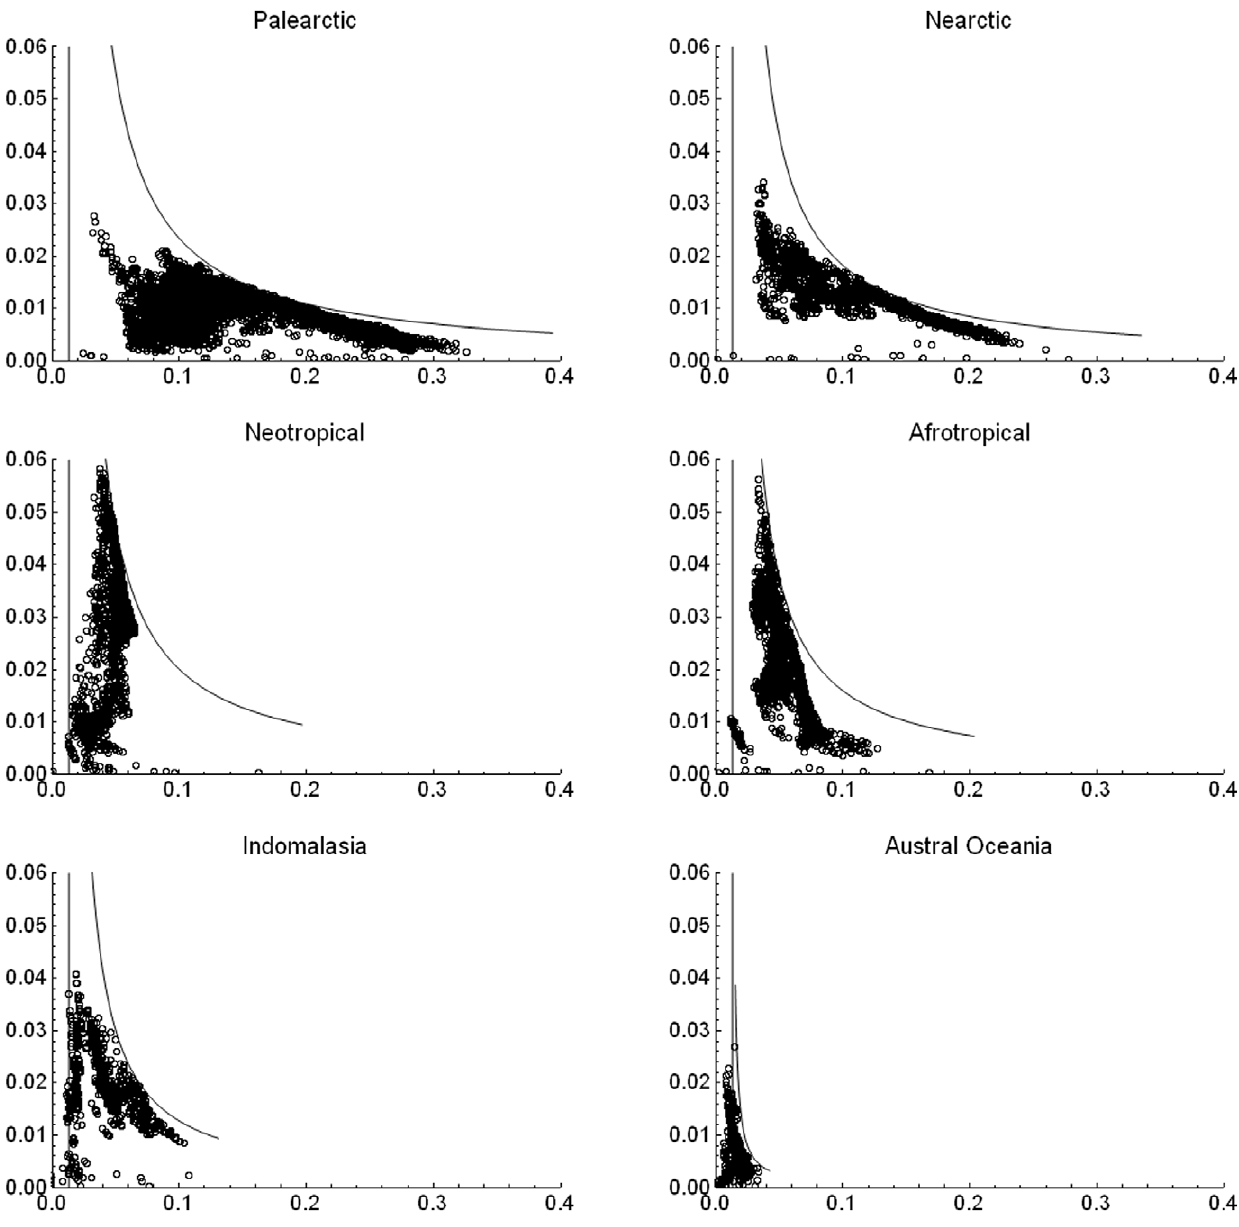
Figure 3. Range-diversity plot of the mammals in different biogeographical realms. The value of 1 = b W =1/75.93 is the same for all the graphs because a single global PAM is used. Curved lines as in Figure (2) with maximum among-sites covariance: Palearctic (cid:2) tt =2.0 6 10 2 2 , Nearctic (cid:2) tt =1.58 6 10 2 3 , Neotropical (cid:2) tt =1.70 6 10 2 3 , Afrotropical (cid:2) tt =1.39 6 10 2 3 , Indo-Malay (cid:2) tt =1.10 6 10 2 3 , Austral-Oceania (cid:2) tt =9.5 6 10 2 5 .